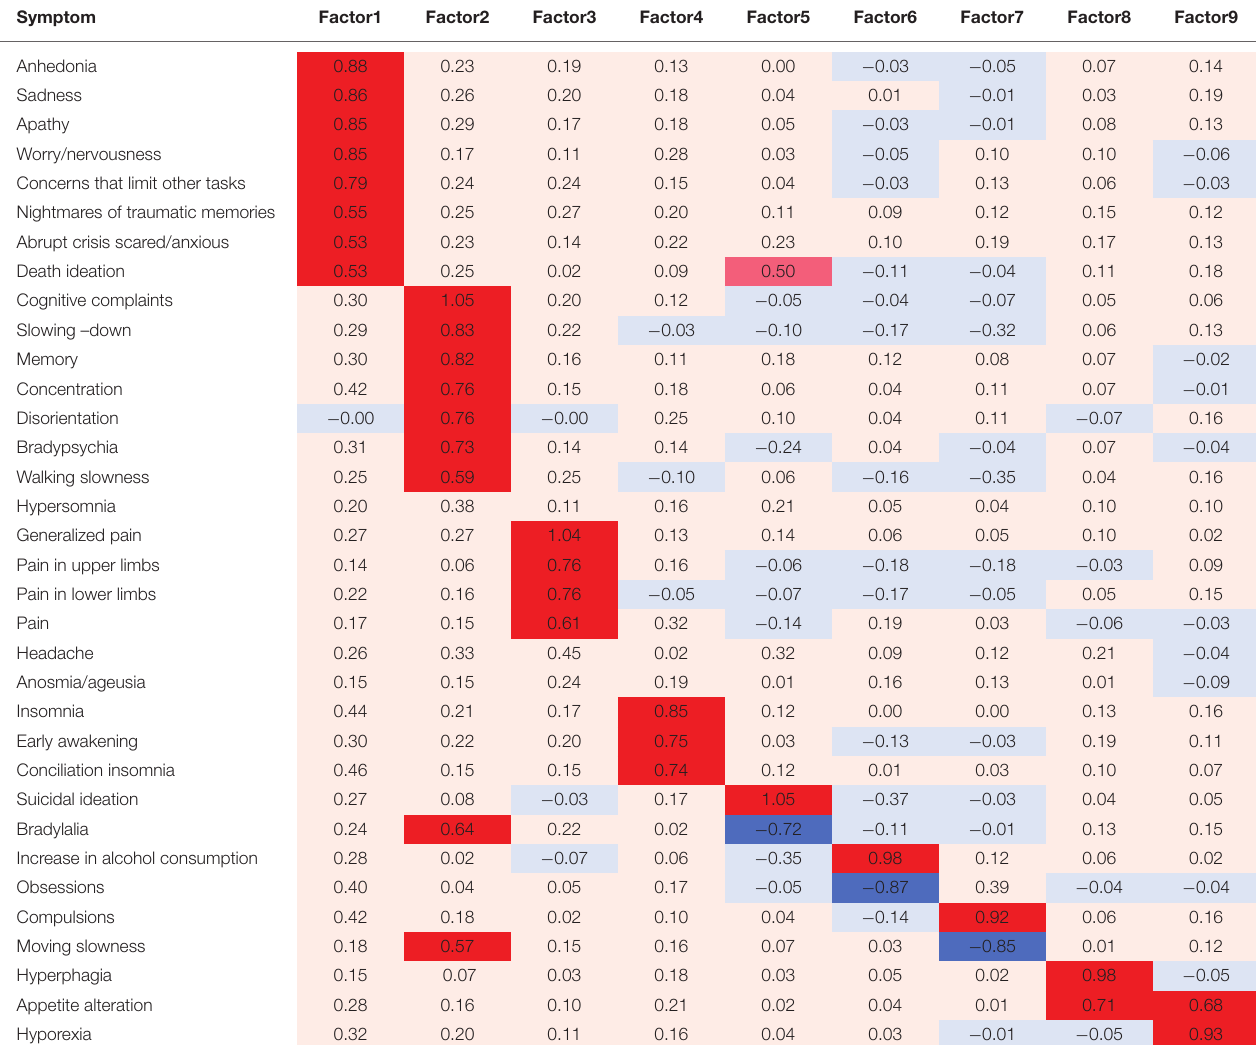
TABLE 3 | Factorial